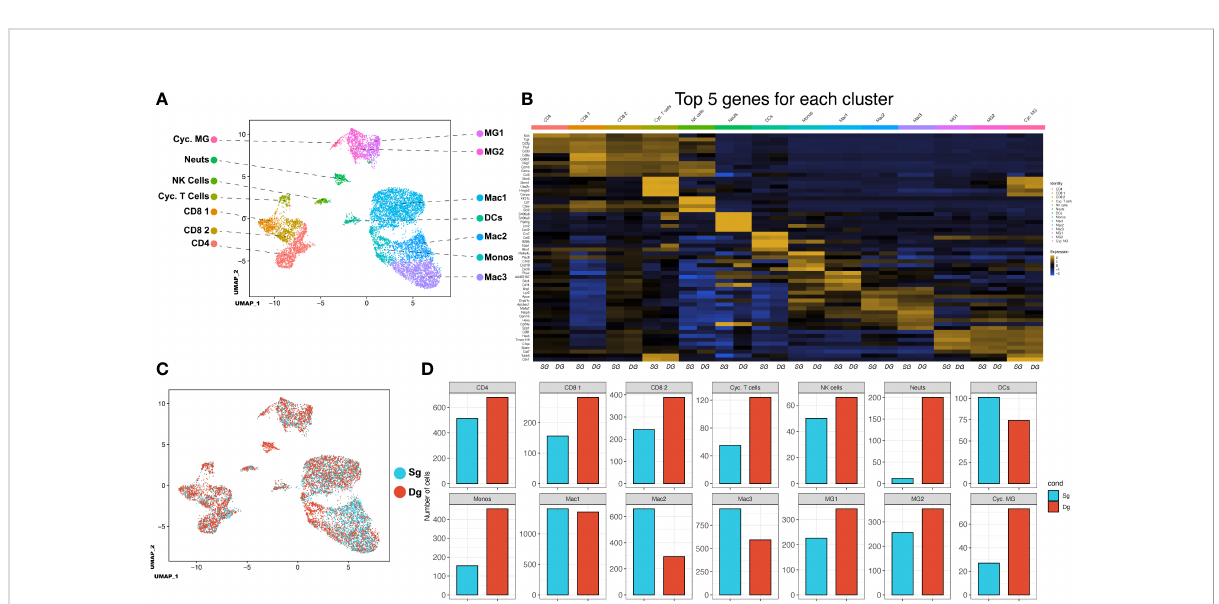
FIGURE 3 scRNAseq of CD45+ cells isolated from spinal cords of JHMV-infected mice. (A) Uniform Manifold Approximation and Projection (UMAP) plot of scRNASeq data revealing 14 distinct cell clusters (aggregate data from JHMV-infected double-tg (n = 4) and single-tg mice (n = 4) treated with doxycycline at 12 days p.i. (B) Heat map showing the top 5 differentially expressed genes with each cluster. Columns show each cluster, with sub columns representing single-tg and double-tg mice; rows specify genes. (C) UMAP plot displaying an overlay of single-tg (blue) and double-tg (red) scRNASeq data. (D) Number of cells per cluster comparing single-tg (blue) and double-tg (red) scRNASeq data from spinal cord at 12 days